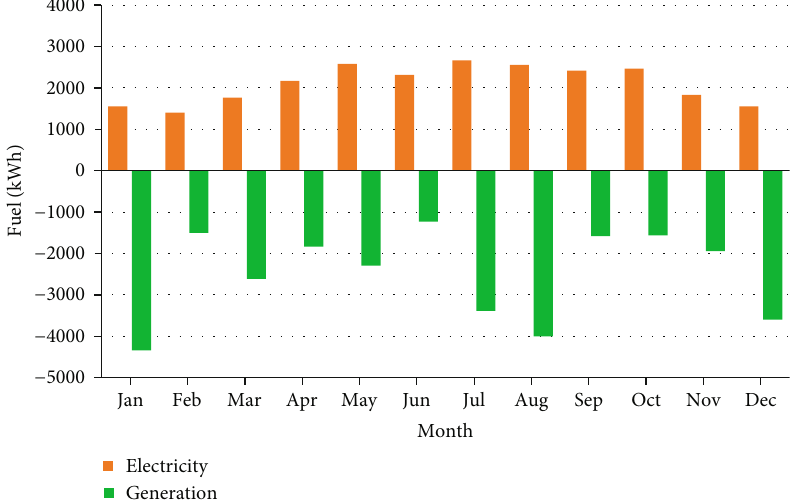
Figure 14: Total monthly produced and consumed loads of the building with consideration of photovoltaic panel and wind turbine